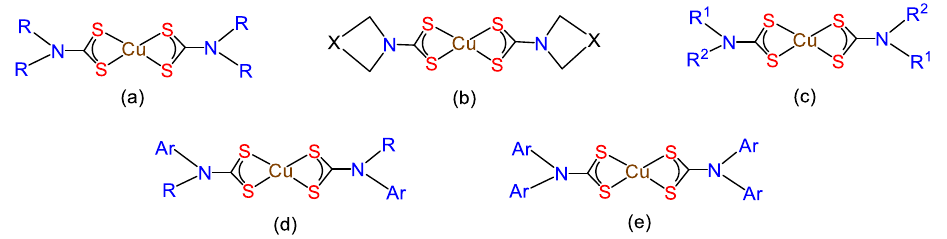
Figure 1. Examples of common Cu(II) bis(dithiocarbamate) motifs ( a ) – ( e ).